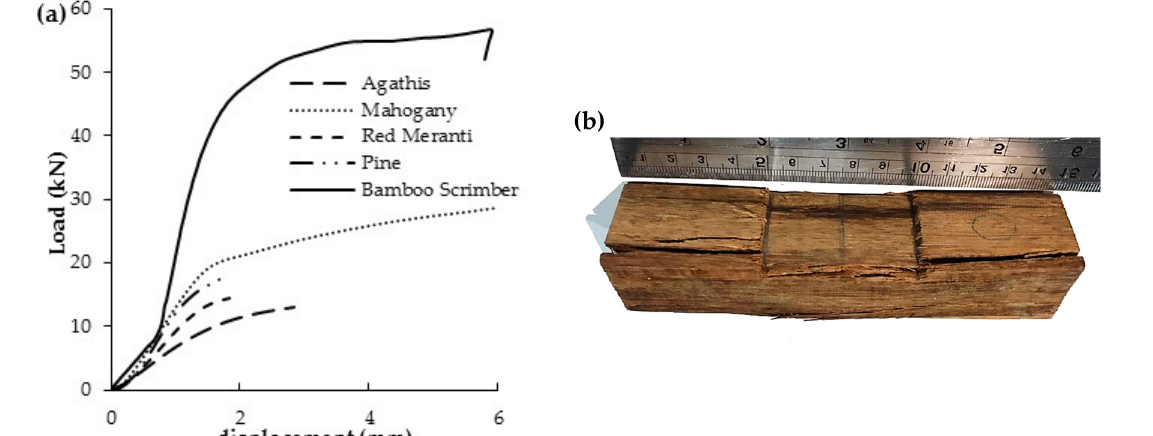
Figure 7. Compression perpendicular-to-fiber ( a ) results and ( b ) specimen failures in scrimber.